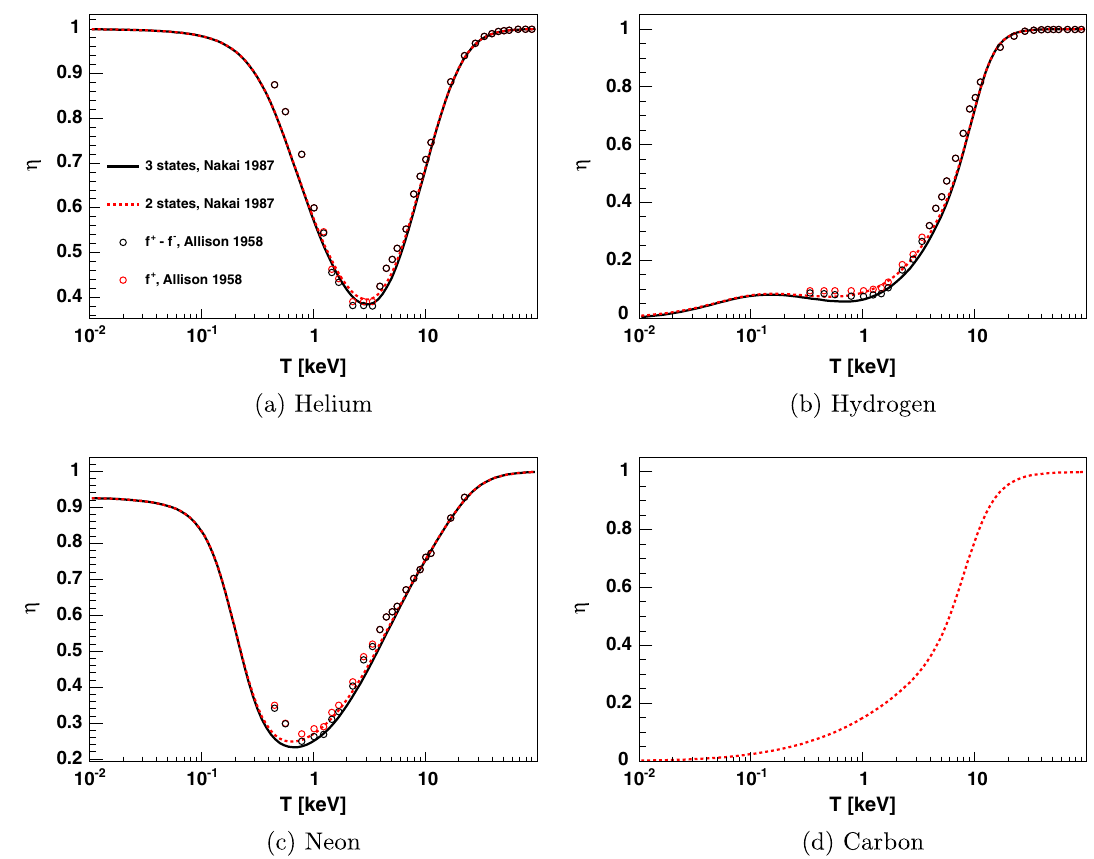
FIG. 3. Effective charge (line) for (cid:1) þ in He, H, Ne, and C for the three-state (solid black) and two-state (dashed red) systems. The data points show the equilibrium charge state fractions taken from